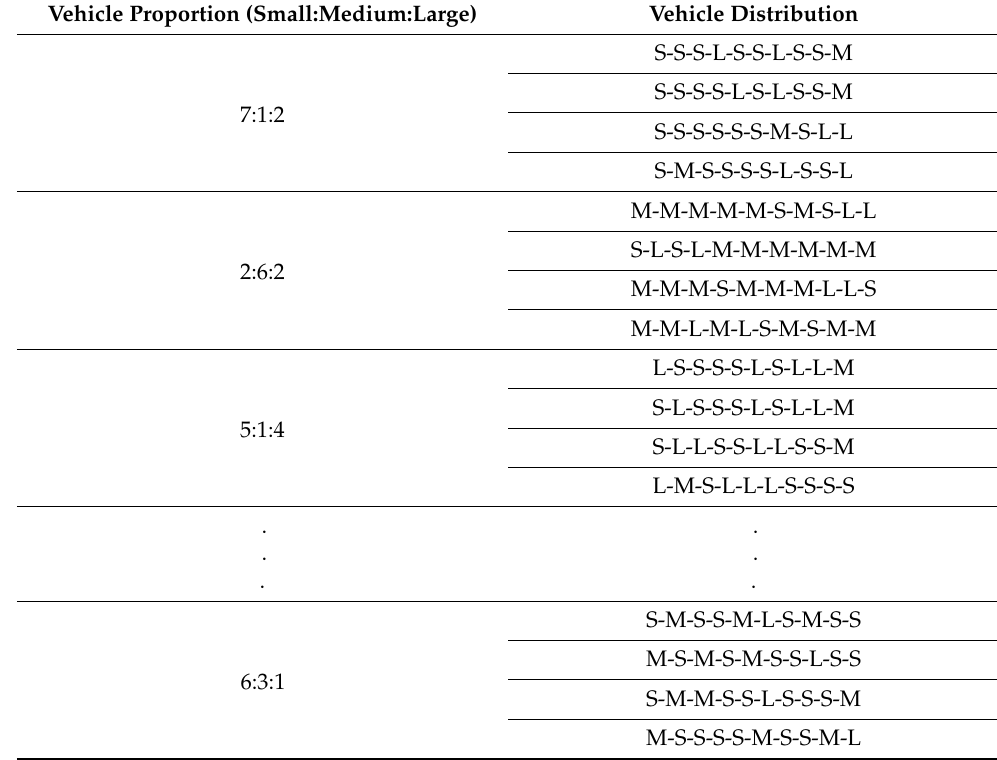
Table 3. CAV platoon composition types (100 in total). Vehicle Proportion (Small:Medium:Large) Vehicle